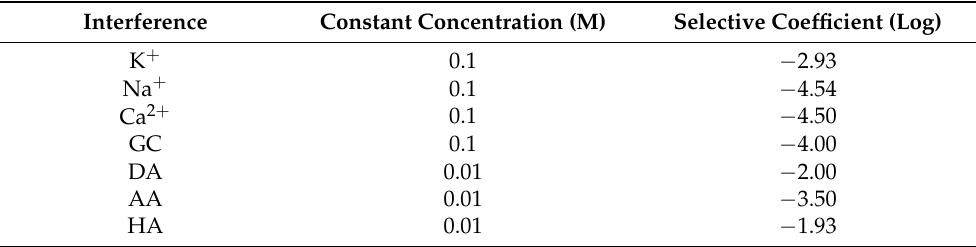
Table 1. Selective coefficients to K + , Na + , Ca 2 + , GC, DA, AA,